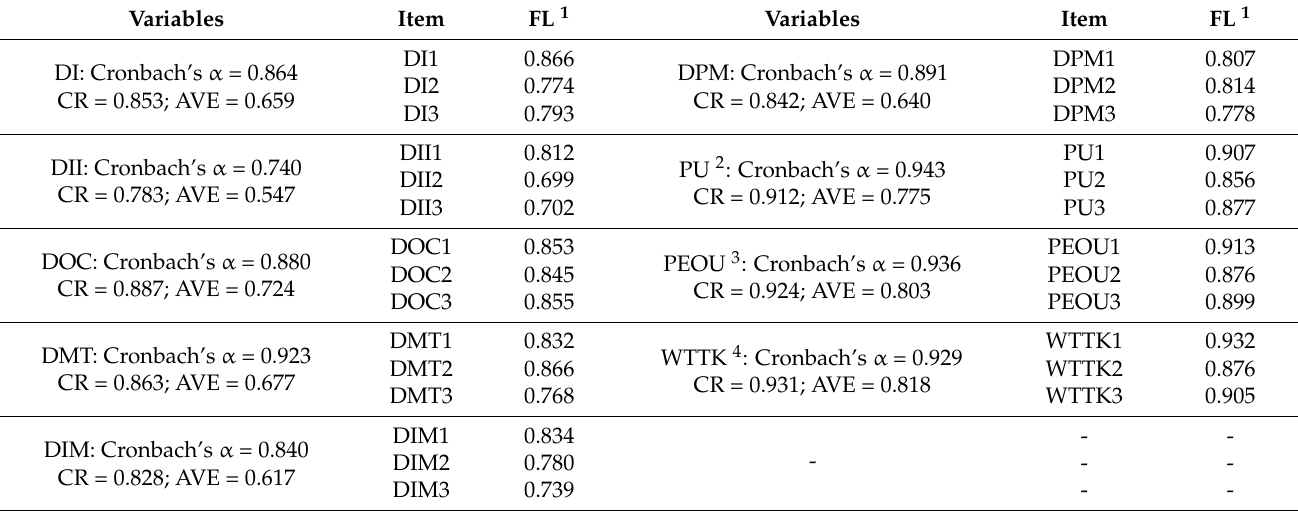
Table 3. Reliability and validity test of the measurement